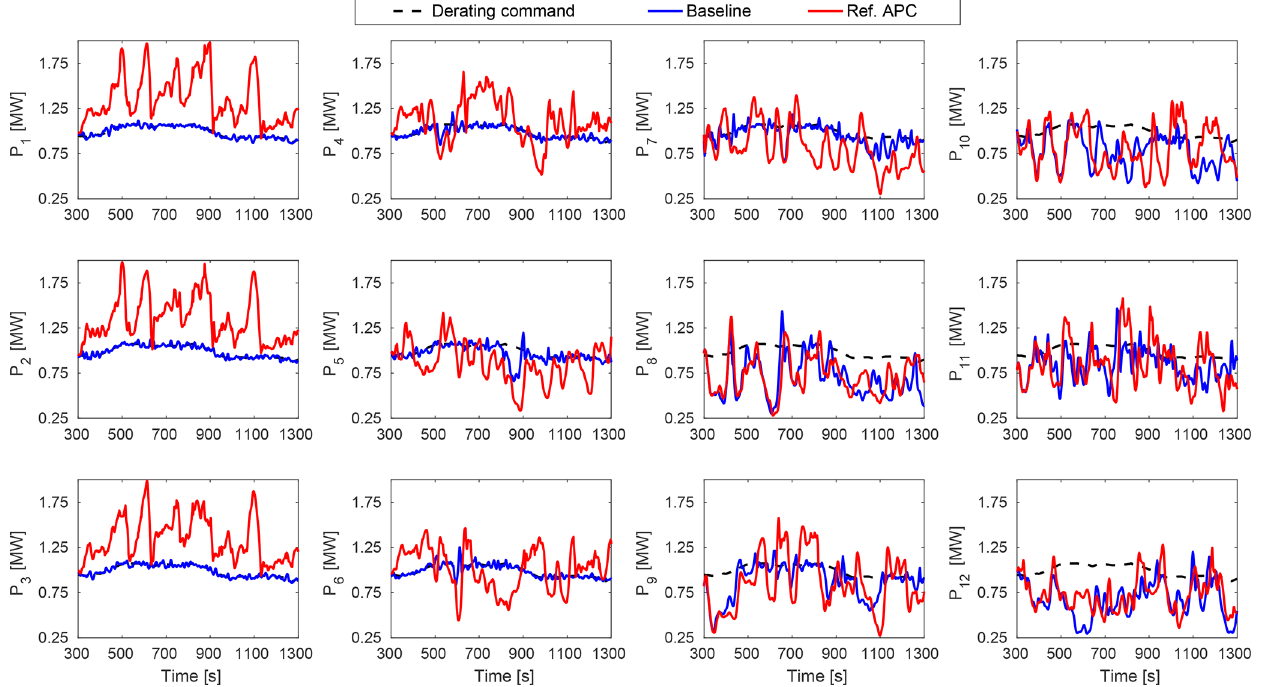
Figure 11. The power productions of the individual wind turbines with the baseline and closed-loop APC for the power reference with = 12 . 3MW, b = 95%, and c = 10%. Both controllers rely on equal power set-points, i.e., α i = 1 / P base farm